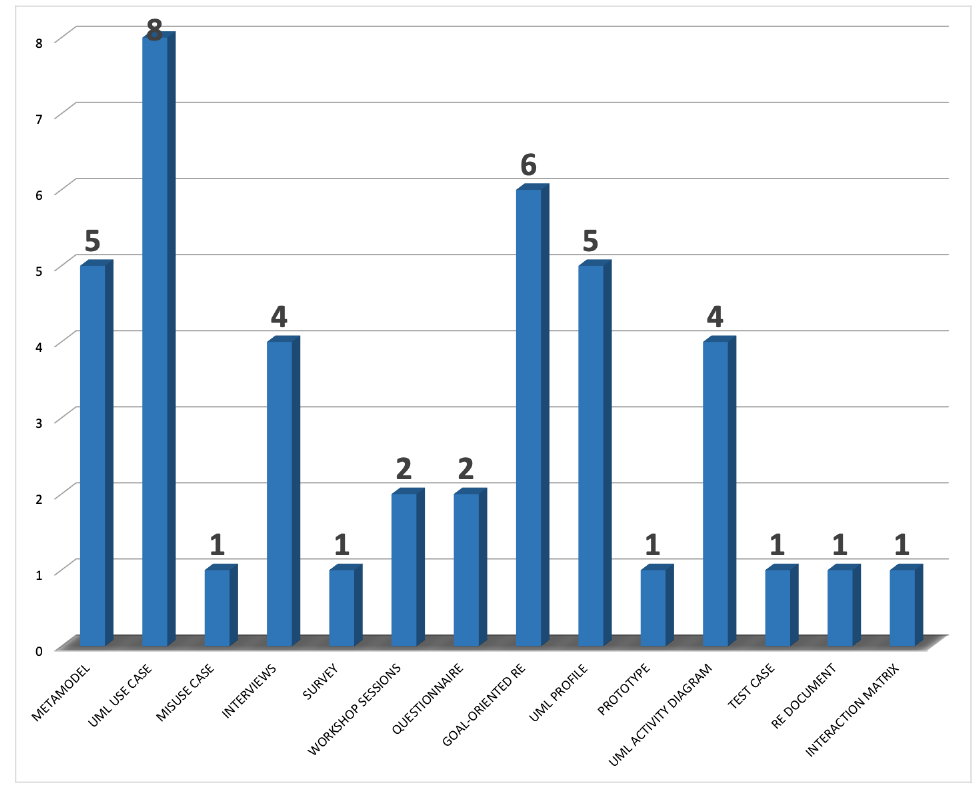
Figure 2. RE techniques applied in the proposals from the primary